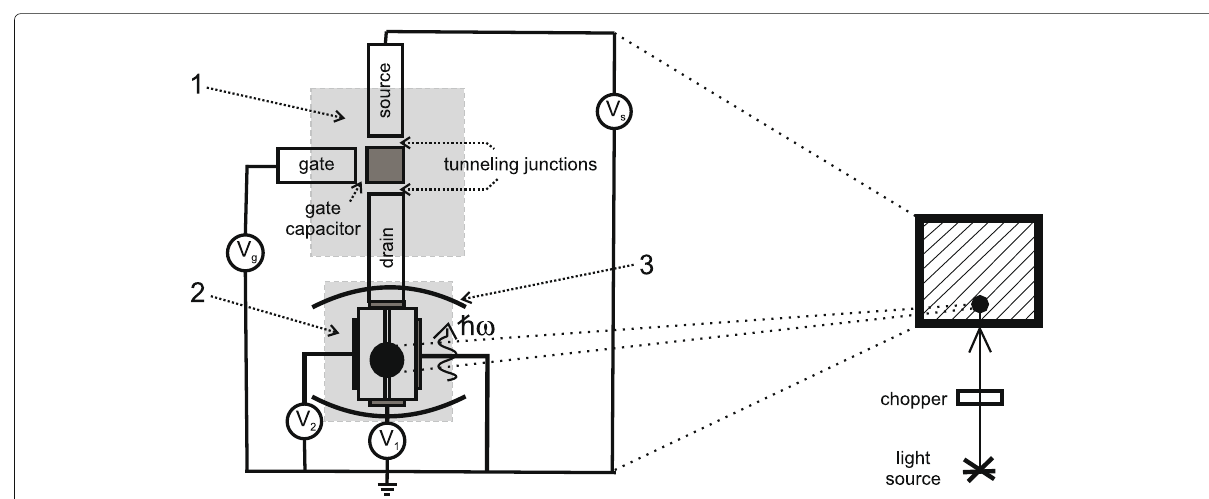
Fig. 3 Layout of possible experiment: 1 —SET, 2 —DQW (see text), and 3